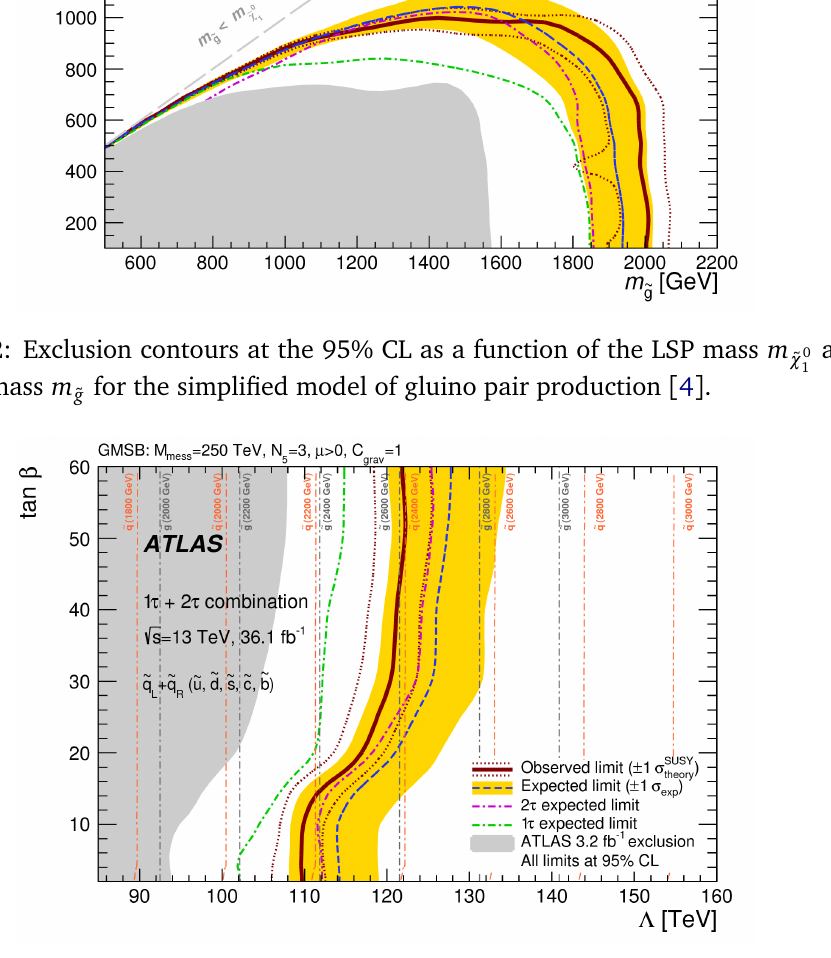
Figure 3: Exclusion contours at the 95% CL as a function of tan β and the SUSY- breaking mass scale Λ for the gauge-med- iated supersymmetry-breaking model [ 4 ]